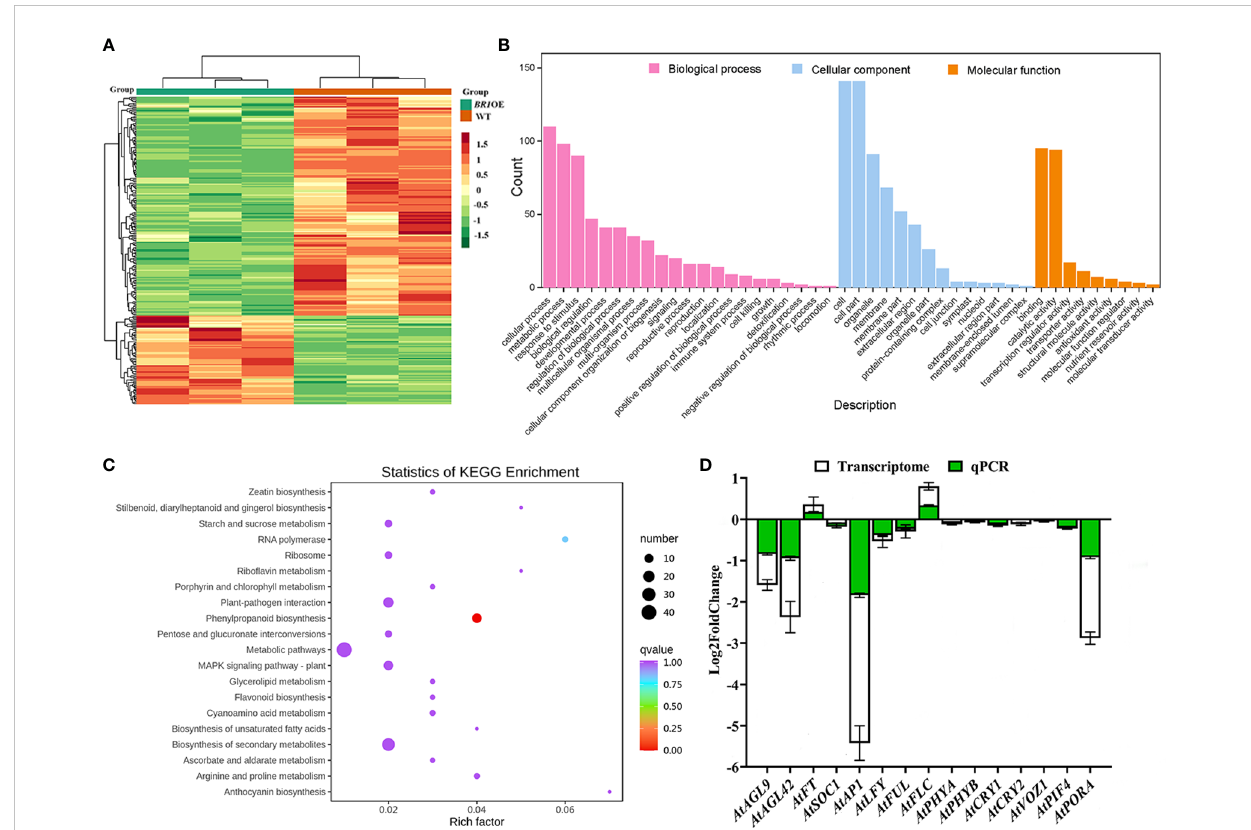
FIGURE 5 Identi fi cation of genes differentially expressed between WT and BR1 OE plants. (A) DEG heatmap analysis. (B) DEG Gene Ontology (GO) classi fi cation was performed, with individual bars denoting the numbers of DEGs mapped to particular GO categories (pink: biological process; blue: cellular component; orange: molecular function). (C) The top 20 most enriched KEGG pathways associated with identi fi ed DEGs. Pathways are provided with the corresponding enrichment factors. (D) qPCR validation of gene expression pro fi